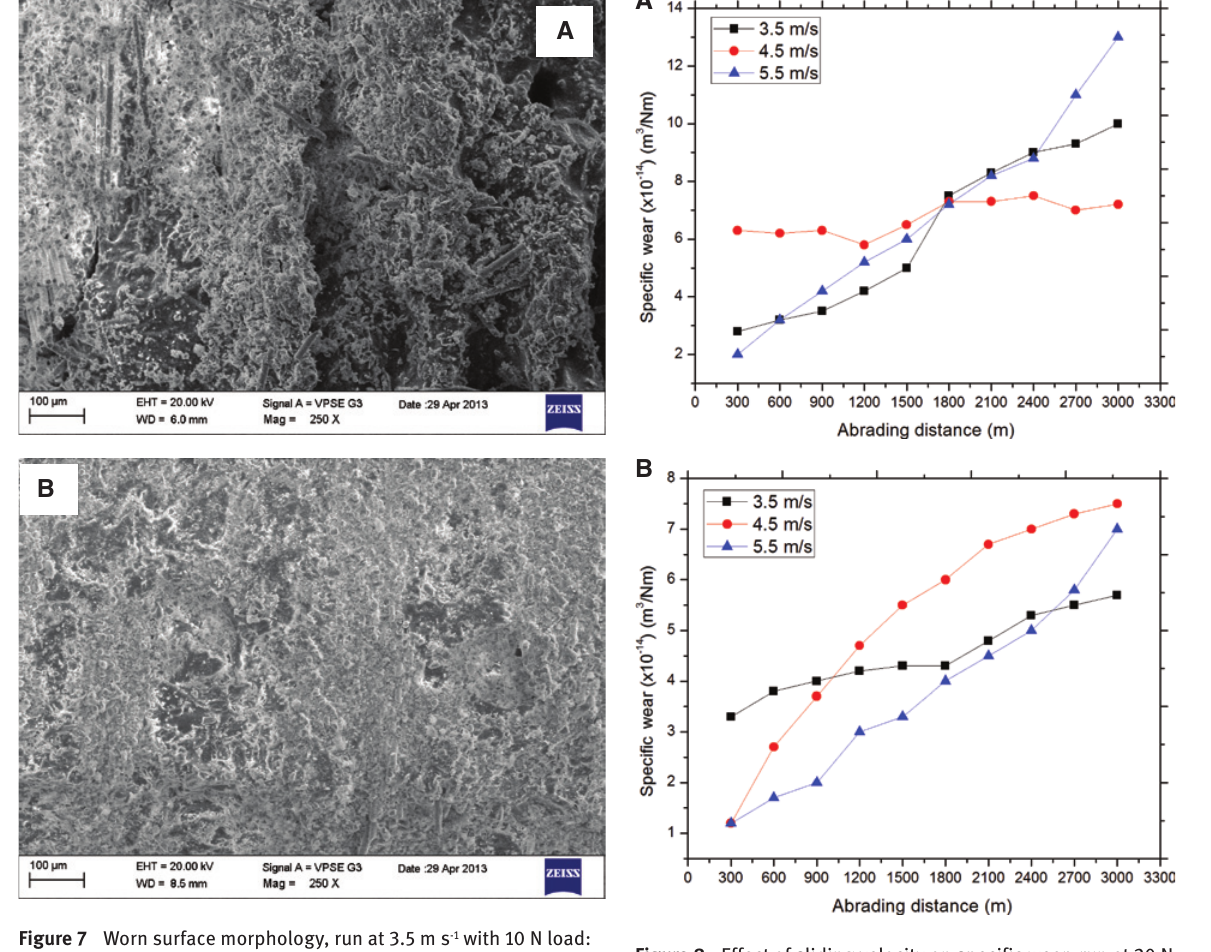
Figure 8 Effect of sliding velocity on specific wear, run at 20 N load: untreated composites (A) and alkali-treated composites